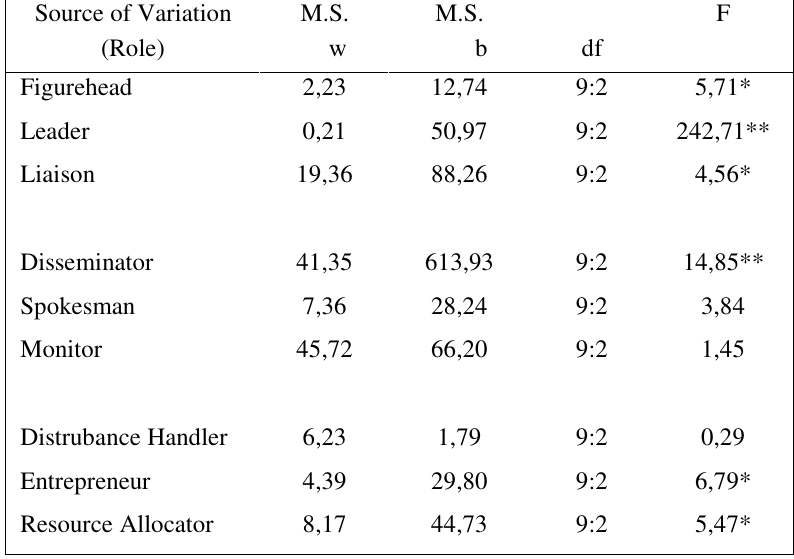
WITHIN EACH INDIVIDUAL ROLE-SET Source of Variation M.S. M.S. F (Role) Figurehead